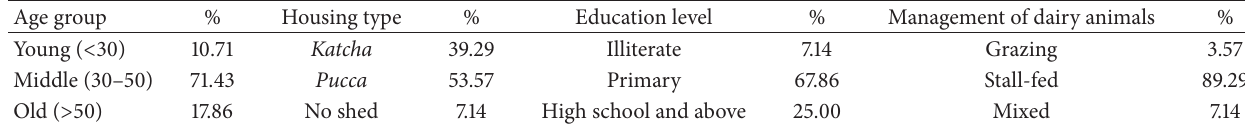
Table 1: Sociopersonal attributes of sample dairy farm owner.